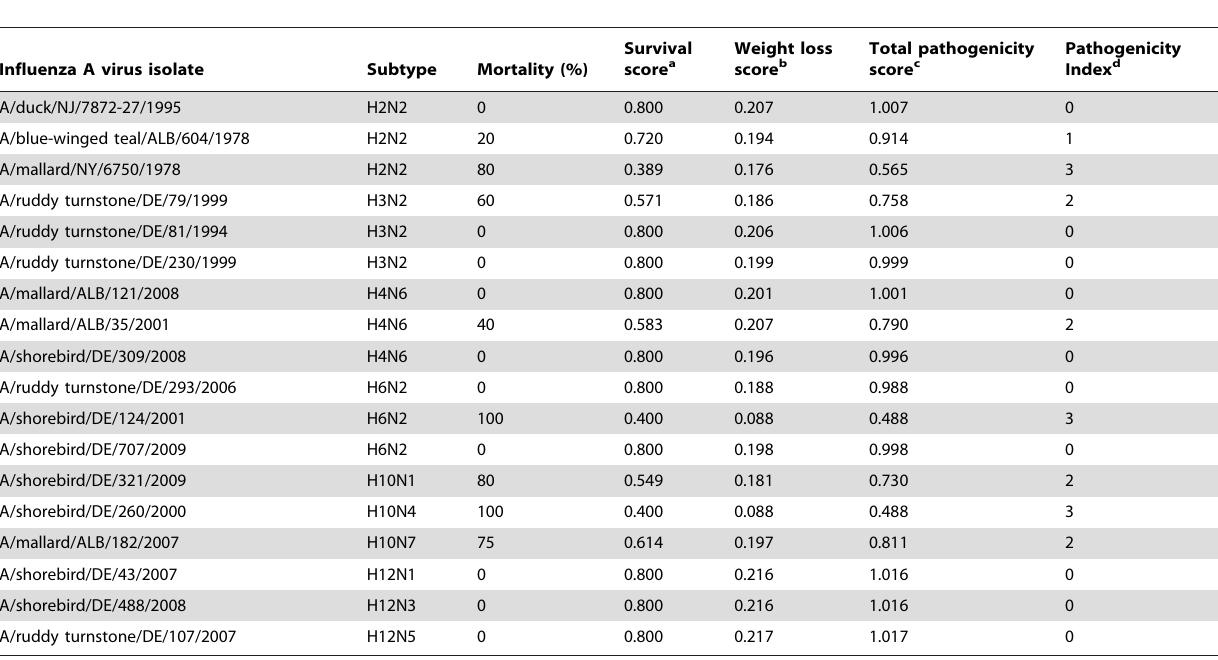
Table 4. Percent mortality and pathogenicity in DBA/2J mice infected with various subtypes of avian influenza A viruses (at 10 6 EID 50